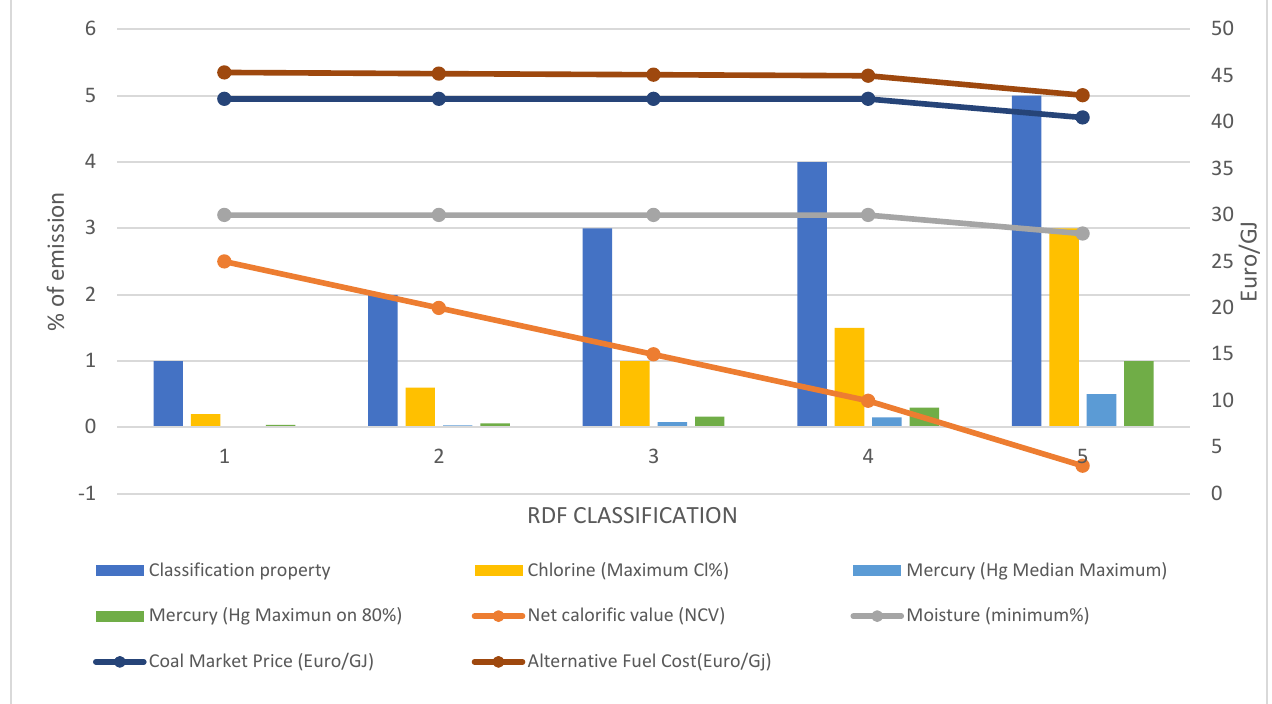
Figure 2. Solid-derived fuel characterizations for a modern kiln. Table 6. Cost estimate of MBT with cement plant pre- and co-processing in